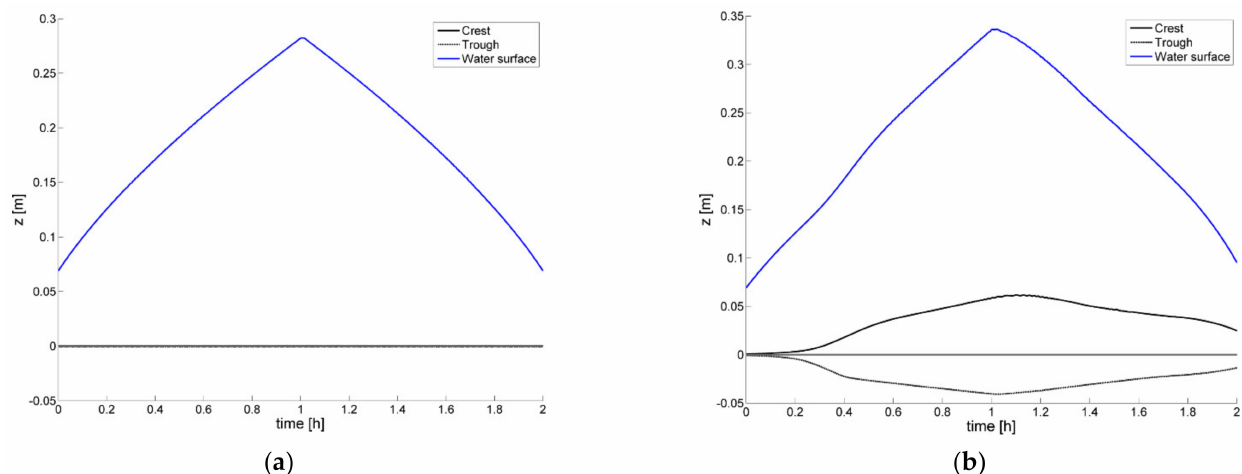
Figure 4. Dune crest and trough position (black lines) and water depth (blue line) over time with the step length model of ( a ) Sekine and Kikkawa (1992) [42] and ( b ) Shimizu et al. (2009)